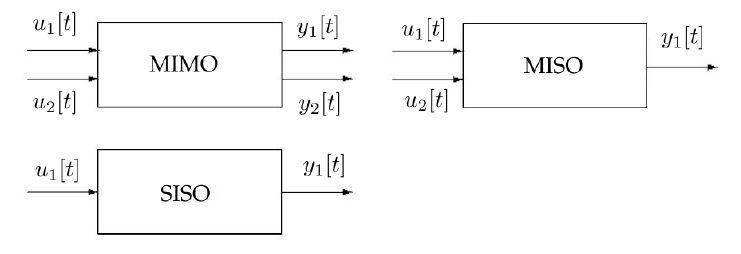
Figure 1. Block diagrams of the possible systems, where the MIMO and MISO systems contain only two inputs u 1 and u 2